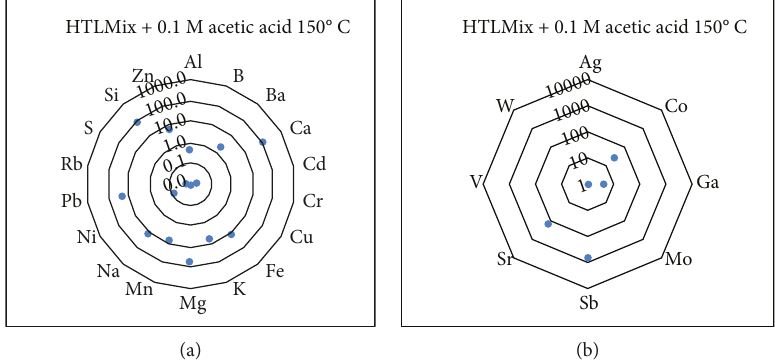
Figure 8: Concentration of the “ common ” ((a) in ppm) and “ at risk ” ((b) in ppb) elements obtained from HTLMix at 150 ° C temperature under 200bar pressure in Ti batch vessel after 1000 hours (absence of data points re fl ects concentrations below the limits of detection).